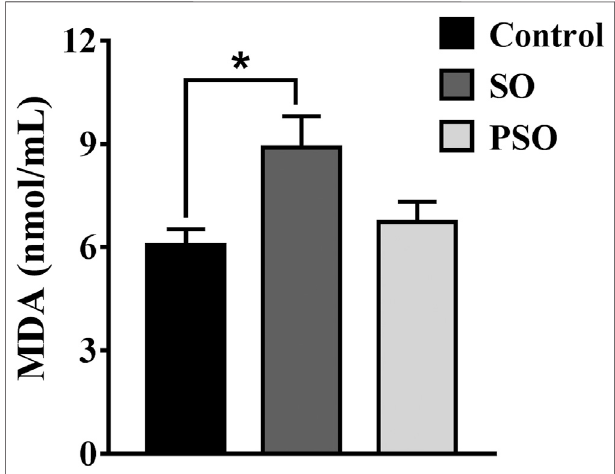
Frontiers in Pharmacology |